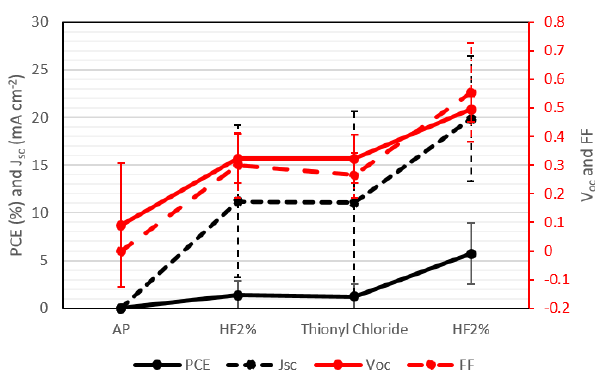
Figure A2. J/V properties for additional devices with slow filtered 400 µL films additional devices.